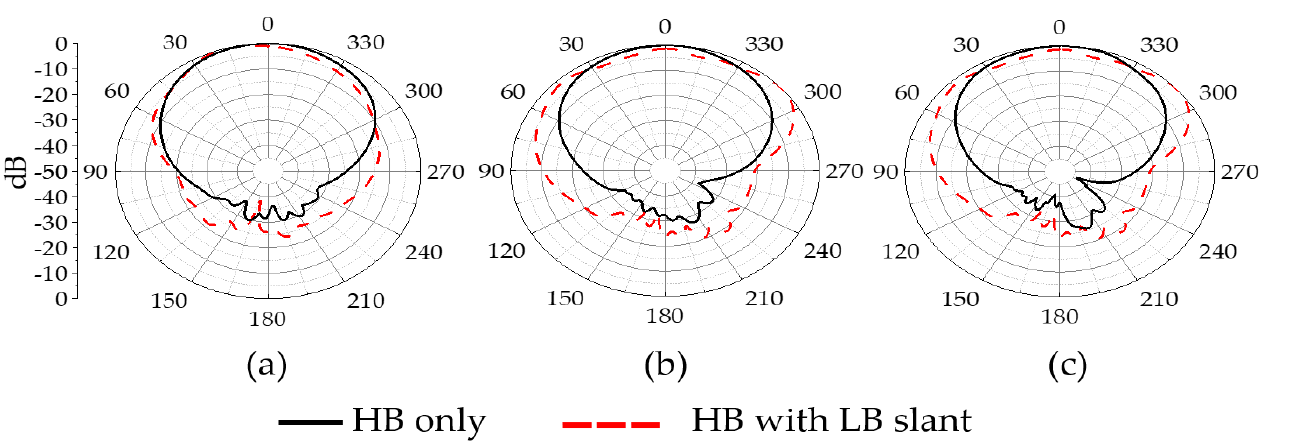
Figure 2. High band-only and high band with slant LB antenna-measured azimuth patterns at ( a ) 1.8 GHz, ( b ) 2.4 GHz and ( c ) 2.6 GHz.